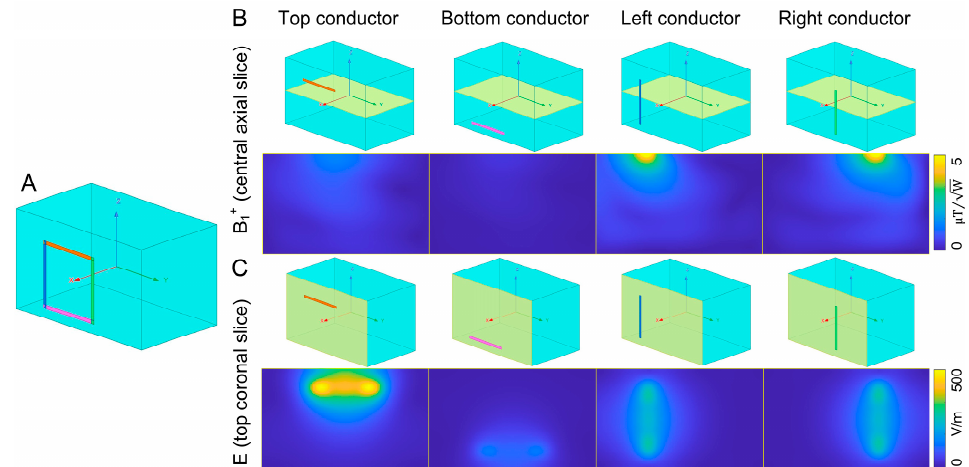
Figure 1. Simulation model ( A ) and results ( B , C ) demonstrate that the B 1 and E fields are determined by different conductors in a self-decoupled coil. B 1 is determined by the arm conductors (left and right conductors, blue and green in Figure 1A), while the maximum local E field is determined by the feed conductor (orange in Figure 1A).